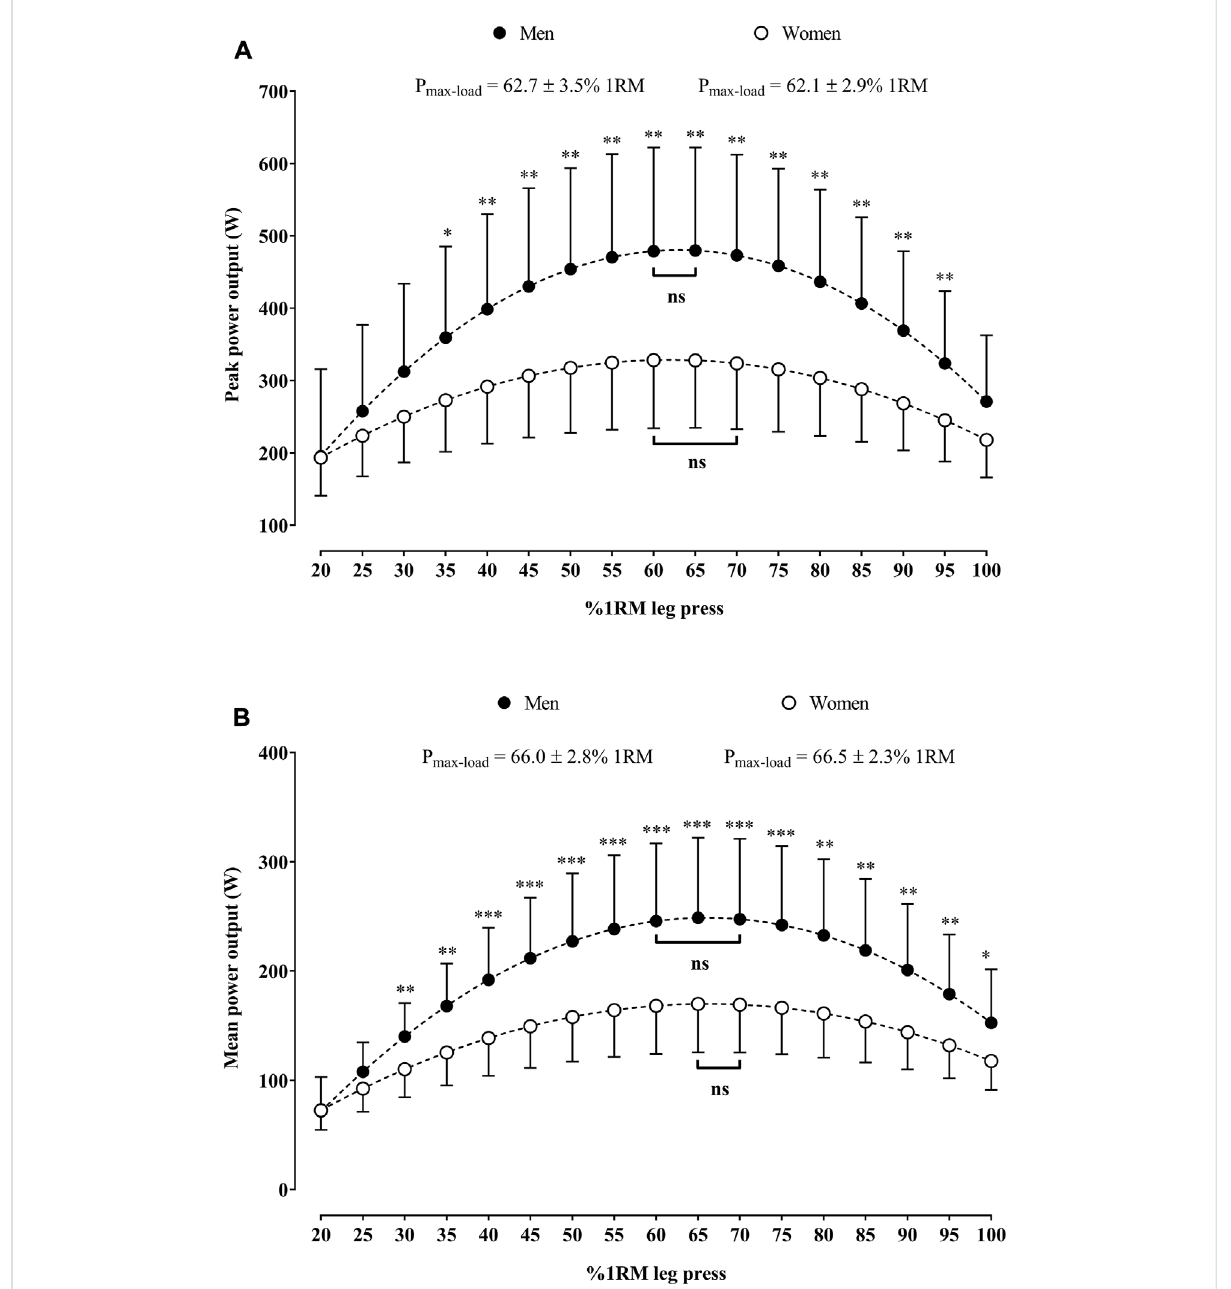
FIGURE 2 Load-peak (A) and mean power (B) relationships in the leg press for older women and men. * p < 0.05, ** p < 0.01, and *** p < 0.001 indicate signi fi cant differences between sexes in the absolute mean or peak power against the same relative load. Square brackets indicate the range of relative loads at which the power output was not statistically different (ns) than the P max-load . Abbreviation: P max-load , relative load that maximizes the power output; RM, repetition